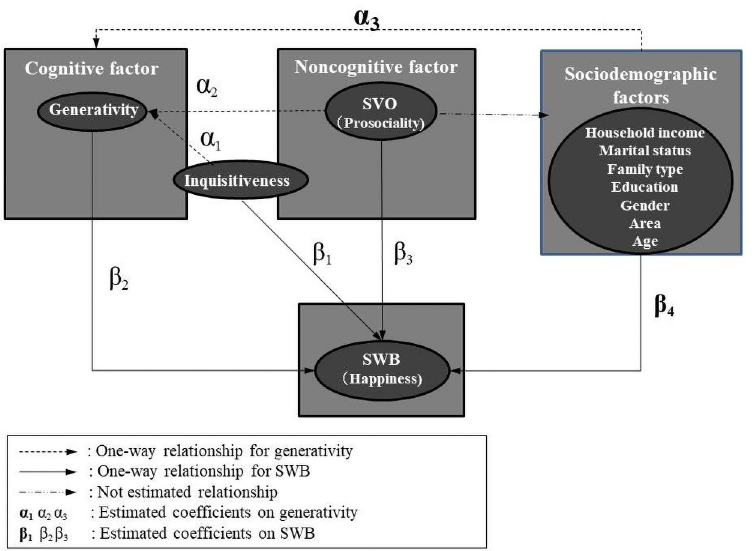
Fig 1. A conceptual framework. A conceptual framework describing the relationships concerning SWB among cognitive, noncognitive and sociodemographic factors.